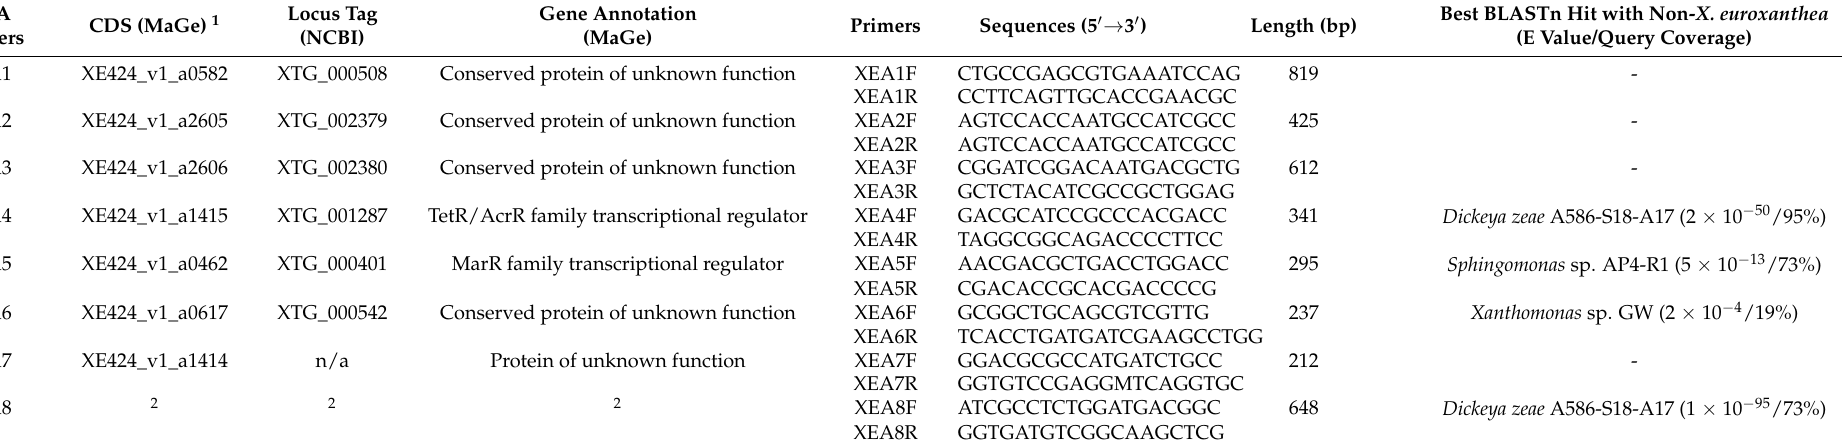
Table 3. Selected Xanthomonas euroxanthea -specific DNA markers (XEA1-XEA8), corresponding primer pair sequences, expected amplicon sizes and best BLASTn hits of amplicons with non- X. euroxanthea